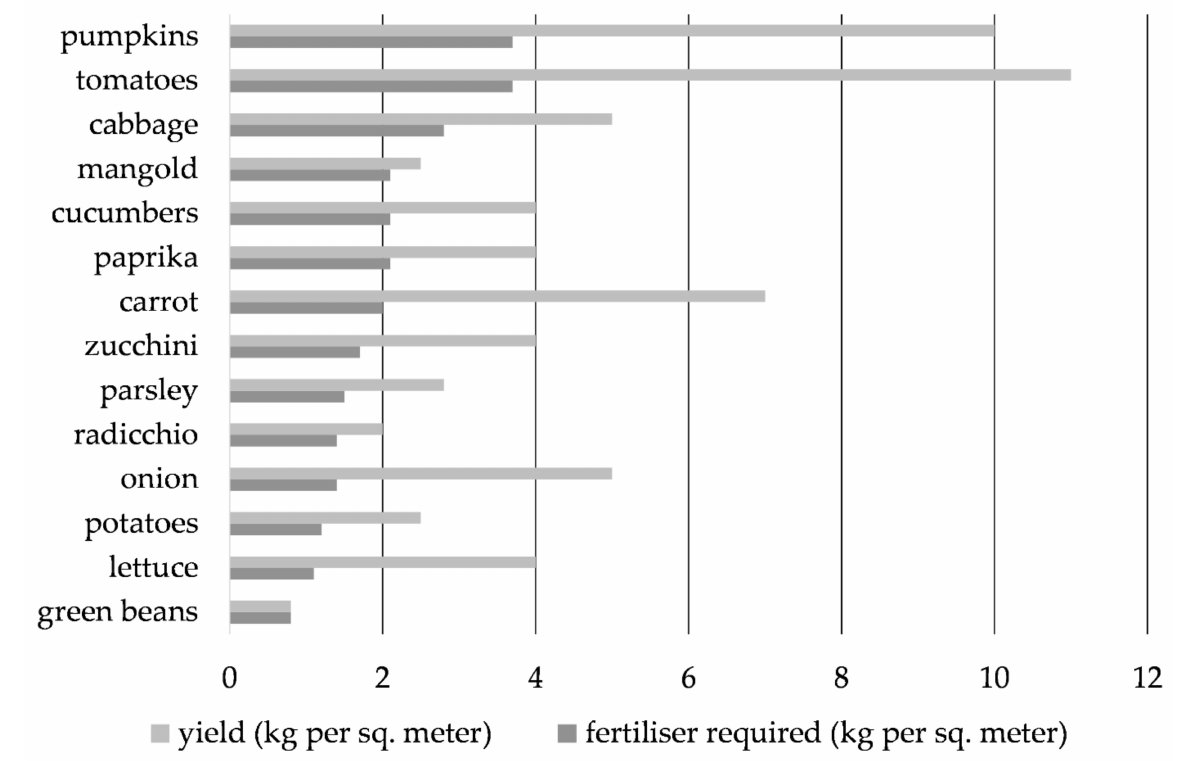
Figure 4. Required application of organic fertilizer (OF) (kg/m 2 ) from F. japonica (1.59% N, 0.19% P, 1% K; assumed recovery efficiency for N 46%) based on the expected yield, following the Technological instructions for integrated vegetable production [39] for selected crops in non-marketable urban gardening in Ljubljana, Slovenia, at a given expected yield (kg/m 2 ) reported by Glavan et al.